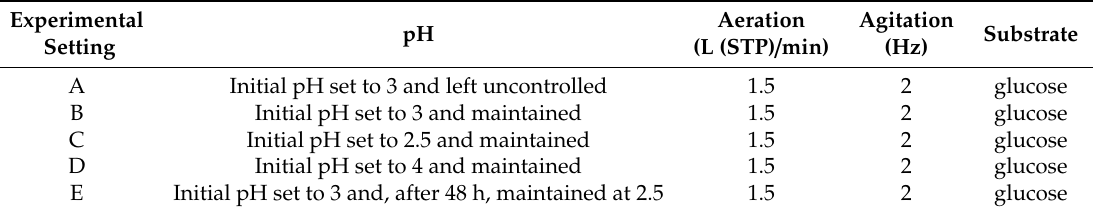
Table 1. The pH setting strategies tested in this